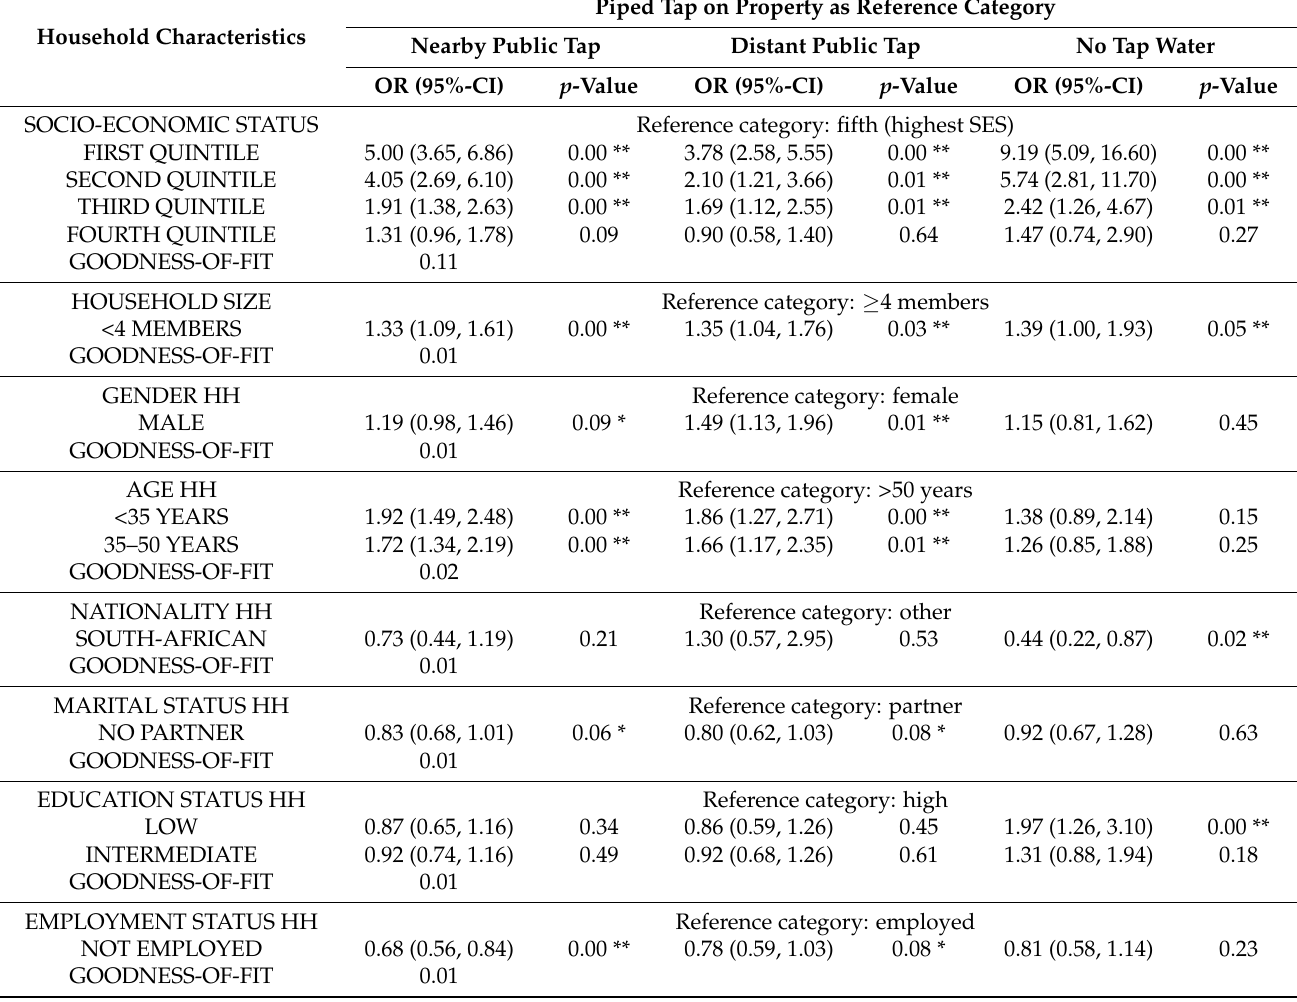
Table A1. Results of univariate multinomial logistic regression analyses showing the associations between household characteristics and drinking water